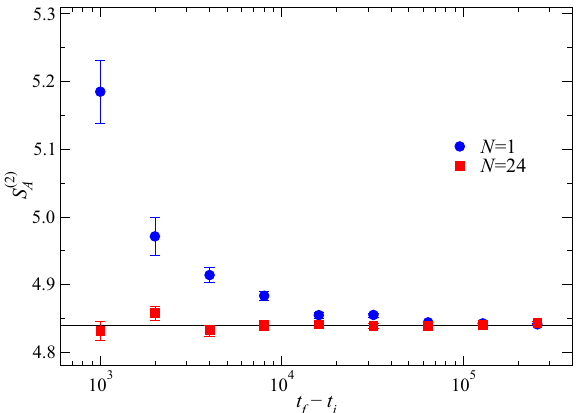
Fig. 7 Convergence of EE for different quench time. The 2nd Rényi entanglement entropy S ð 2 Þ of a 2D antiferromagnetic Heisenberg A model on a 32 × 16 torus versus the quench time t f − t i for the nonequilibrium increment method with the total number of nonequilibrium pieces taken to be N = 1 and N = 24. The entangling region A is a 16 × 16 lattice which is chosen as depicted in the inset of Fig. 1. SEM is used when estimating the errors of the physical